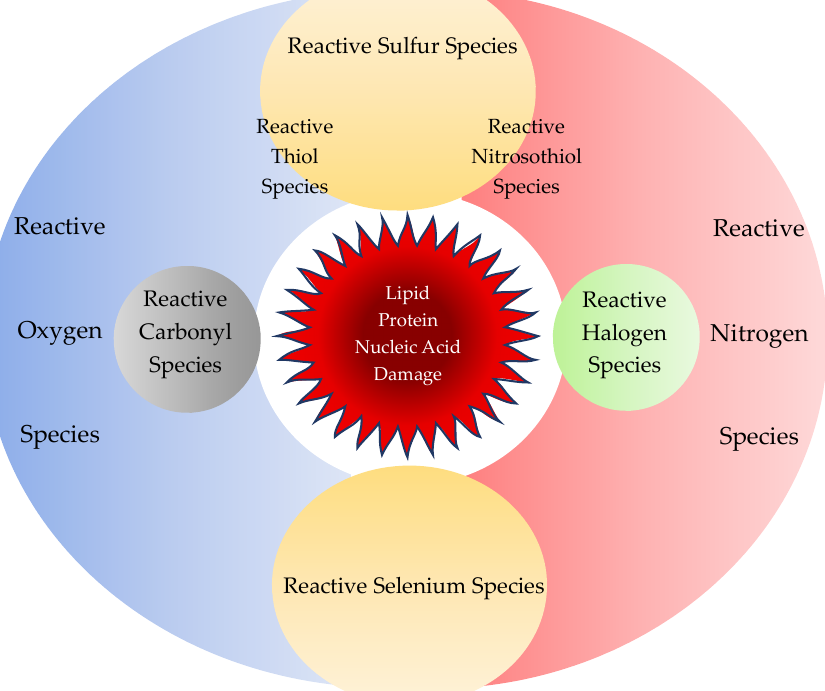
Figure 2. Reactive chemical species. Reactive chemical species comprise of not only reactive oxygen species and reactive nitrogen species, but also reactive sulfur, carbonyl, halogen, and selenium species. Sulfur reacts with oxygen or nitrogen to form reactive thiol or nitrosothiol species, respectively. All reactive chemical species react in concert during regular cellular activity but may cause oxidative stress to damage cellular components such as proteins, lipids, and nucleic acids.